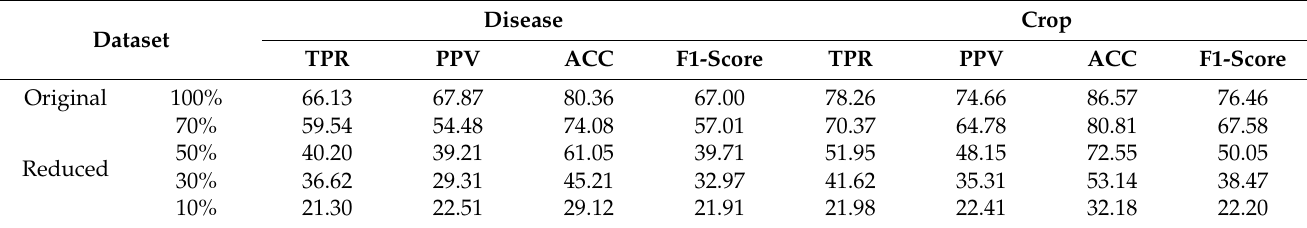
Table 17. Comparison of accuracies achieved by the proposed PI-CNN in the original and reduced datasets. The accuracies were achieved in the PlantDoc dataset (unit: %).